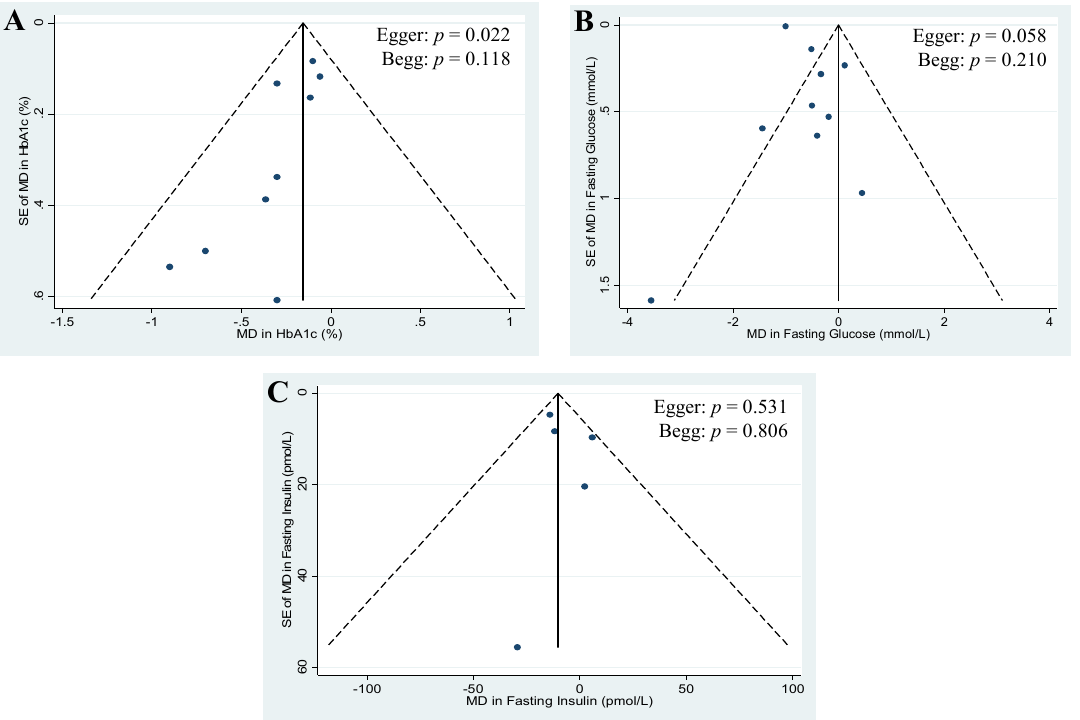
Figure 5. Publication bias funnel plots for HbA 1c ( A ), fasting glucose ( B ), and fasting insulin ( C ). The solid line represents the pooled effect estimate expressed as the weighted mean difference (MD) for each analysis; the dashed lines represent pseudo ‐ 95% confidence limits; and the circles represent effect estimates for each included study. p ‐ values displayed in the top right corner of each funnel plot are derived from quantitative assessment of publication bias by Egger and Begg tests set at a significance level of p < 0.05; SE, standard error.